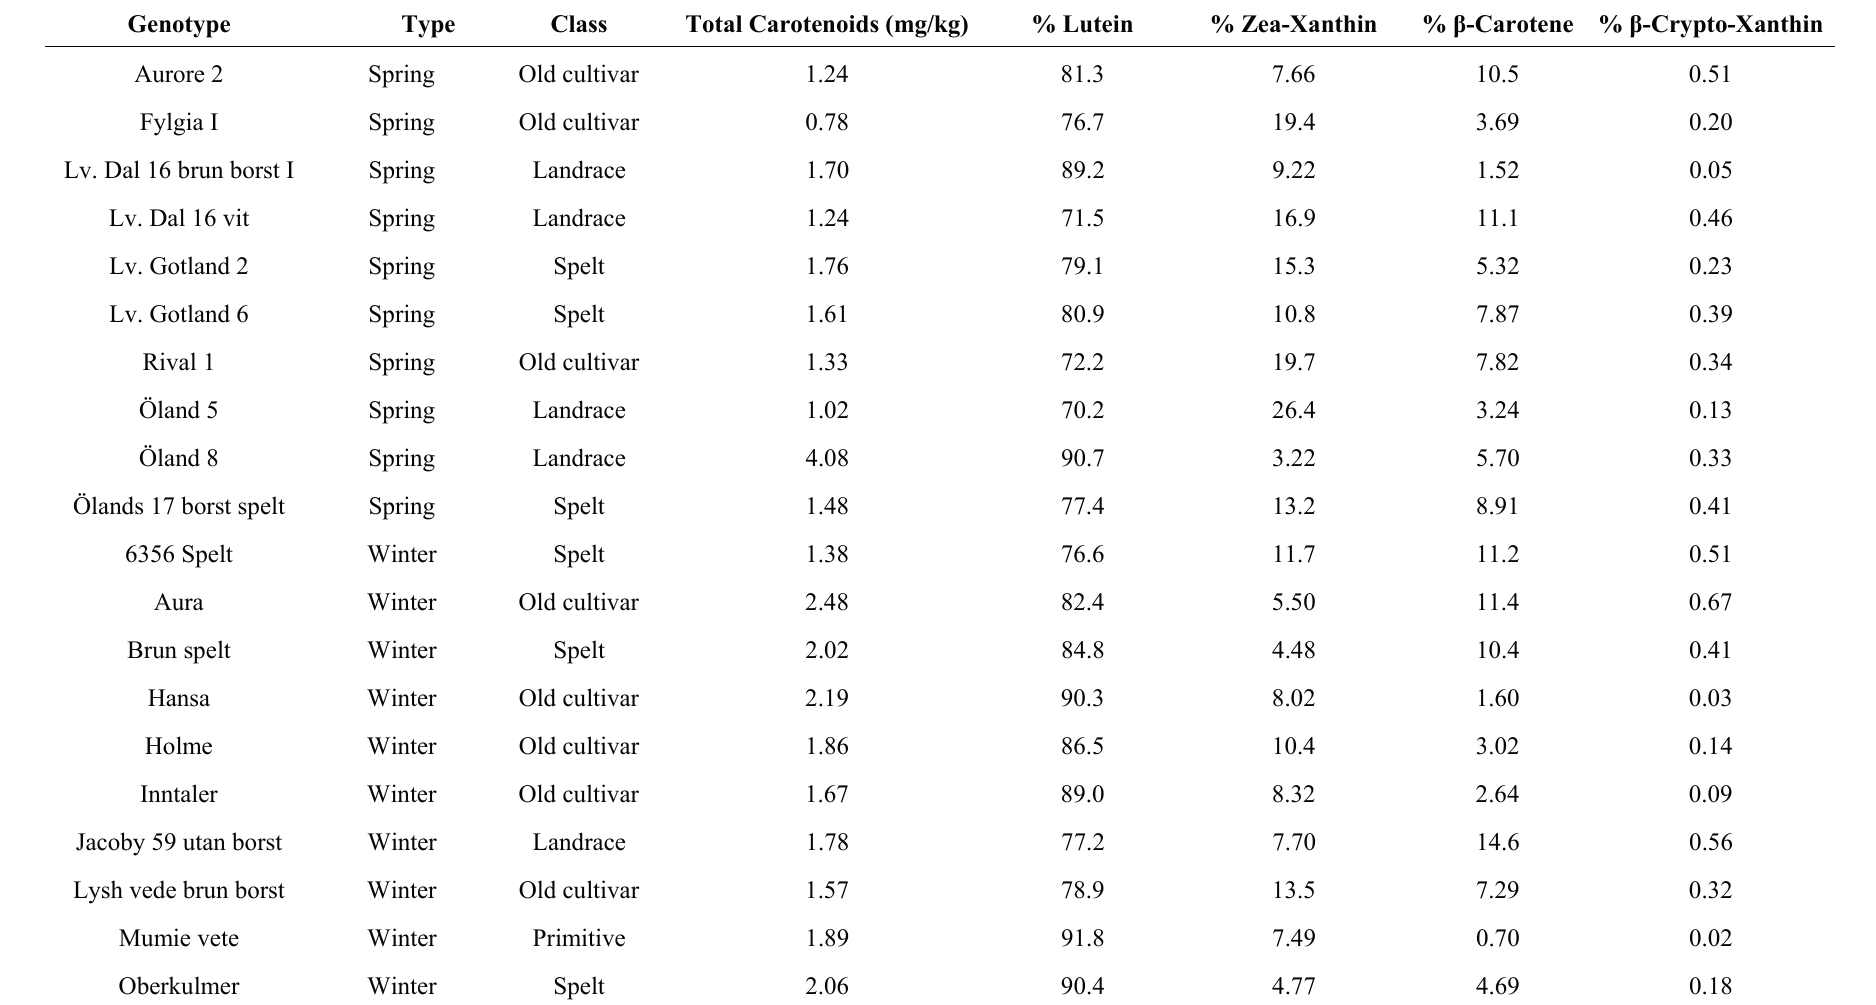
Table 1. Genotype name, type and classes of wheat used in the study, and total content of carotenoids in each sample as well as % of different carotenoid compounds found in the